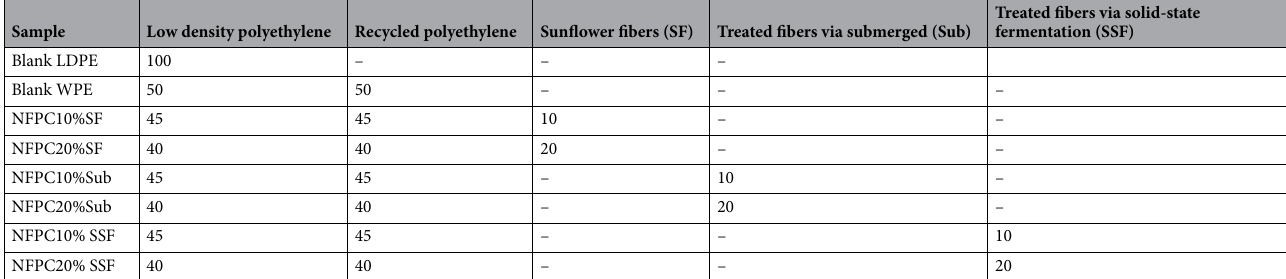
Table 1. The c omposition of the prepared samples (the value by